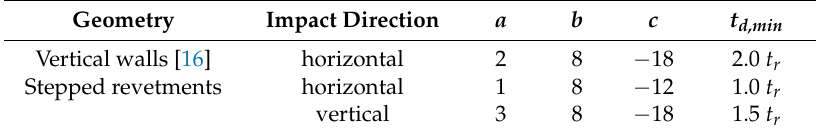
Table 2. Coefficients a , b and c for Equation (5) and corresponding minimal impact duration t d,min . Geometry